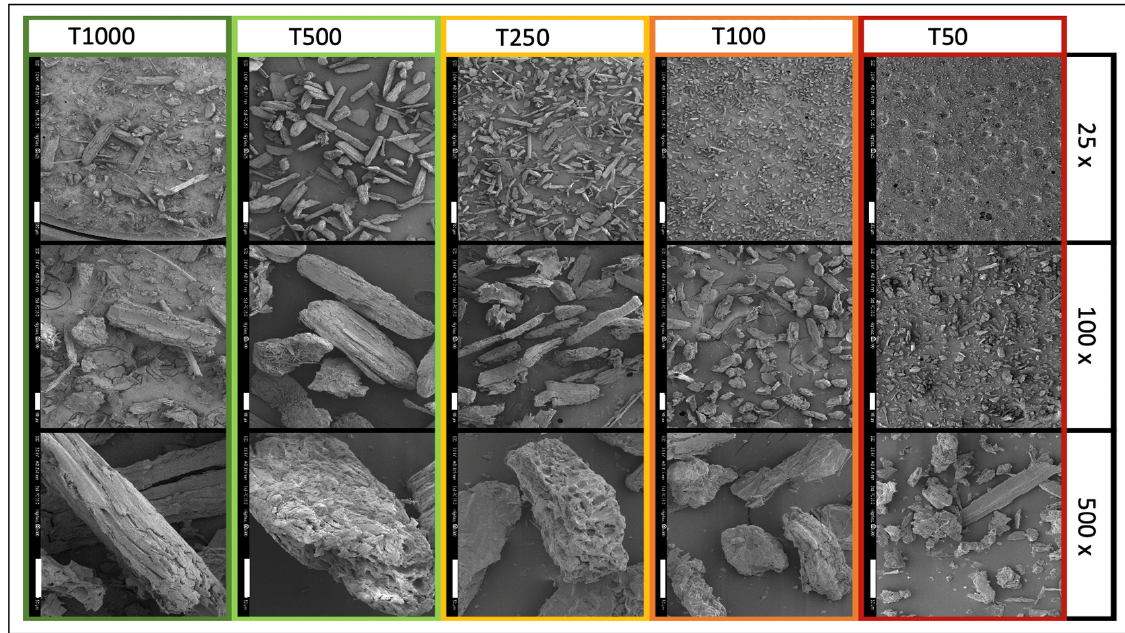
Figure 1. SEM observations of tomato biomass particles at different magnifications. For 25×, 100×, and 500× magnification, the white scale bar corresponds to 500, 100, and 50 mm, respectively.